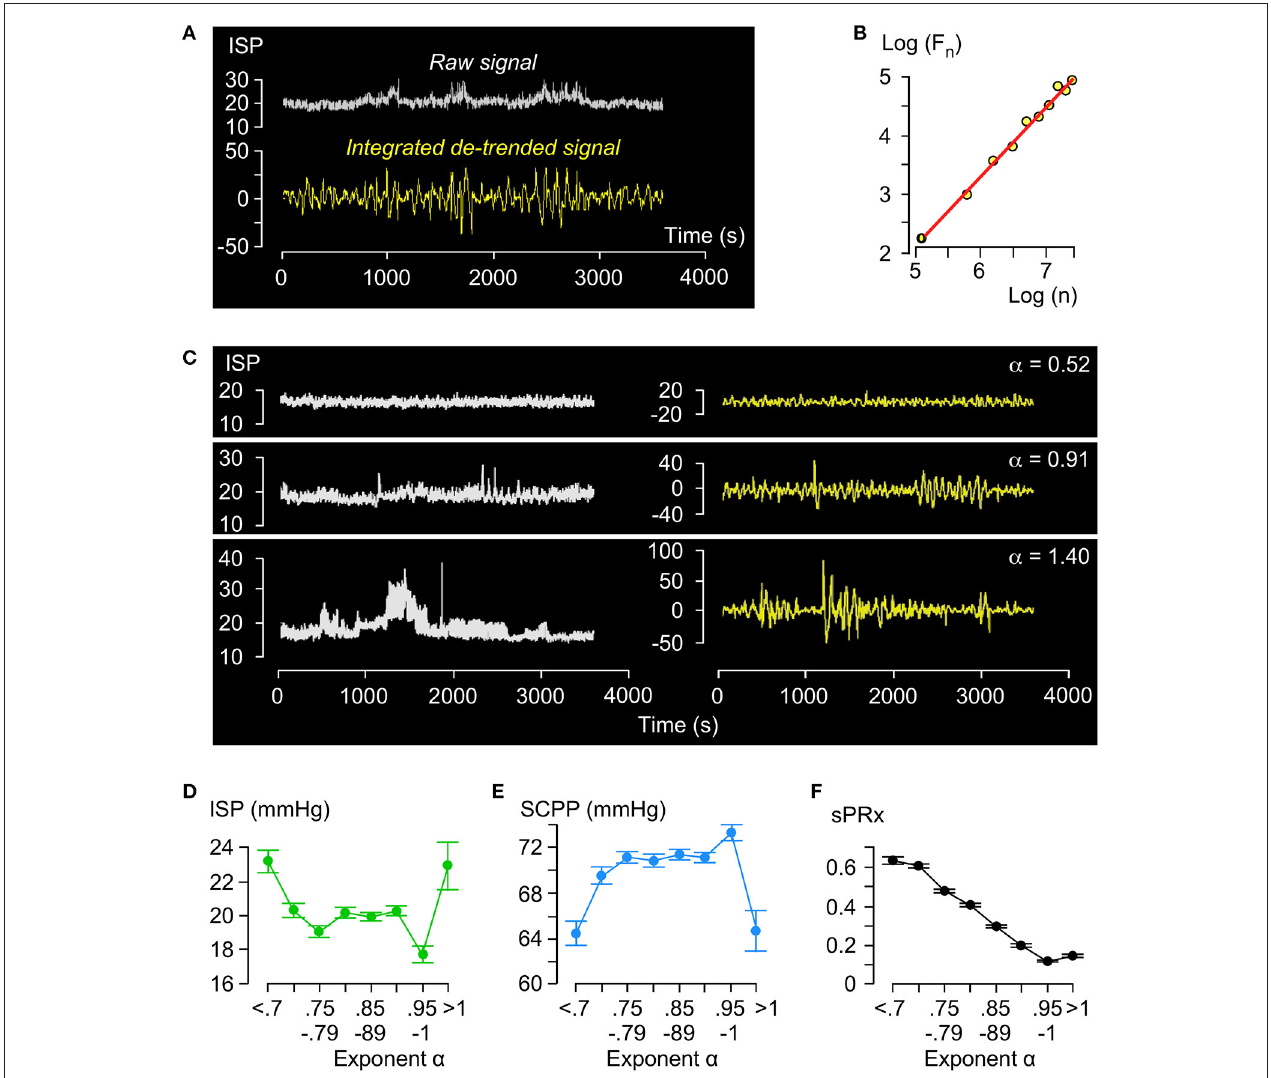
FIGURE 2 | Detrended fluctuation analysis of ISP signal . (A) Example of raw (white, top) and integrated detrended (yellow, bottom) ISP signal. (B) Log F(n) vs. Log n plot and trend-line ( R = 1.00, slope = α ). (C) Raw (white, left) and integrated detrended (yellow, right) ISP signals with increasing α . (D) ISP vs. α (green). Trend-line R = − 0.18. (E) SCPP vs. α (blue). Trend-line R = 0.19. (F) sPRx vs. α (black). Trend-line R = − 0.98. For (C–E) n = 49 patients, mean ± standard